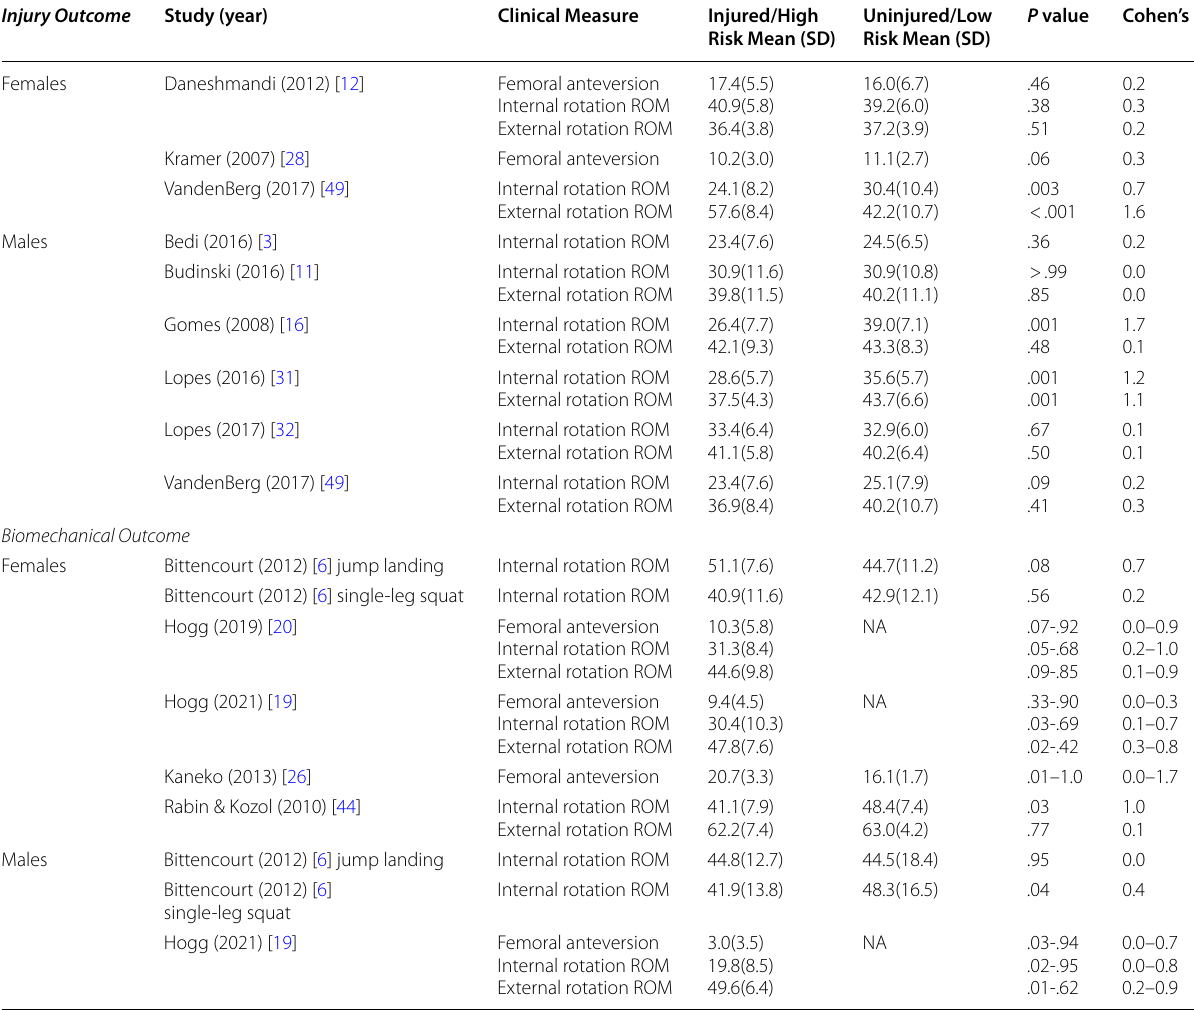
Table 7 Results detailing sex differences in transverse plane femoral alignment in both injury and biomechanical